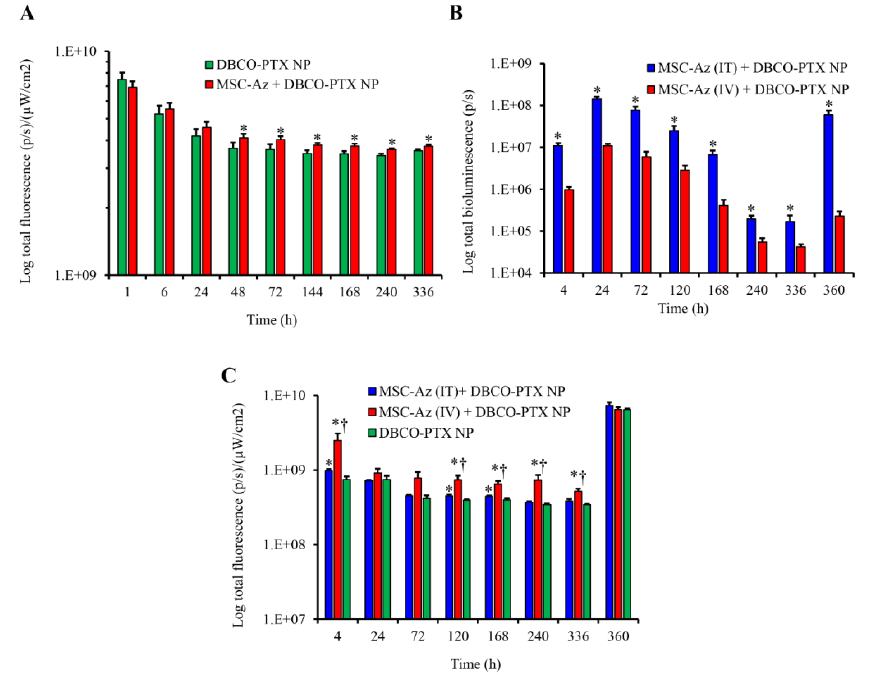
Figure 2. Biodistribution and retention of DBCO-PTX-NIR NP and MSC-Az. ( A ) Biodistribution of DBCO-PTX-NIR NP in C200-Luc orthotopic ovarian tumors ( n = 6). “*” indicates significantly higher ( p < 0.05) than DBCO-PTX NP group. ( B ) Biodistribution and or retention of MSC-Luc-Az in PDX ovarian tumor model; n = 22 for MSC-Az (IV) and n = 18 MSC-Az (IT). At all-time points MSC-IT bioluminescence were significantly higher ( p < 0.05) than MSC-IV group. “*” indicates significantly higher ( p < 0.05) than DBCO-PTX NP group. ( C ) Biodistribution of DBCO-PTX-NIR NP in PDX ovarian tumor model; n = 22 for MSC-Az (IV) and n = 18 for DBCO-PTX NP and MSC-Az (IT) groups. “*” indicates significantly higher ( p < 0.05) than DBCO-PTX NP group and “ † ” indicates significantly higher ( p < 0.05) than MSC-Az + DBCO-PTX NP